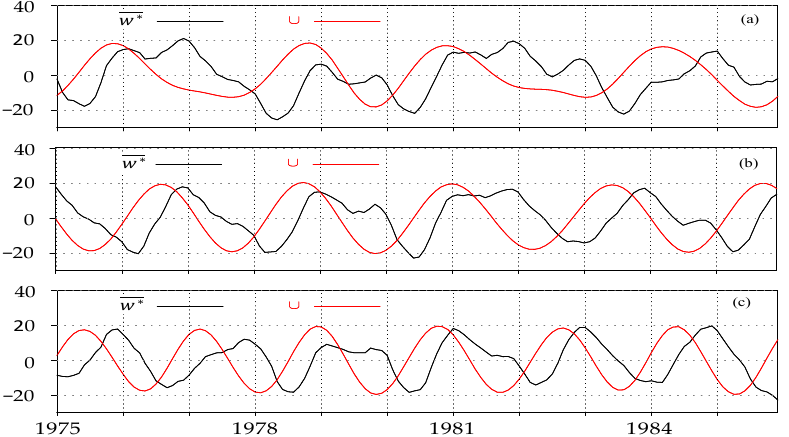
Figure 12. Zonal–mean zonal winds (red) and residual mean vertical velocity anomalies ( w ∗ ) (black) at 20 hPa for the ( a ) P, ( b ) ST, and ( c ) N runs from 1975 to 1985. All the quantities are averaged between 10 ◦ S and 10 ◦ N. Units are in ms − 1 for zonal wind and 10 − 5 ms − 1 for w ∗ .